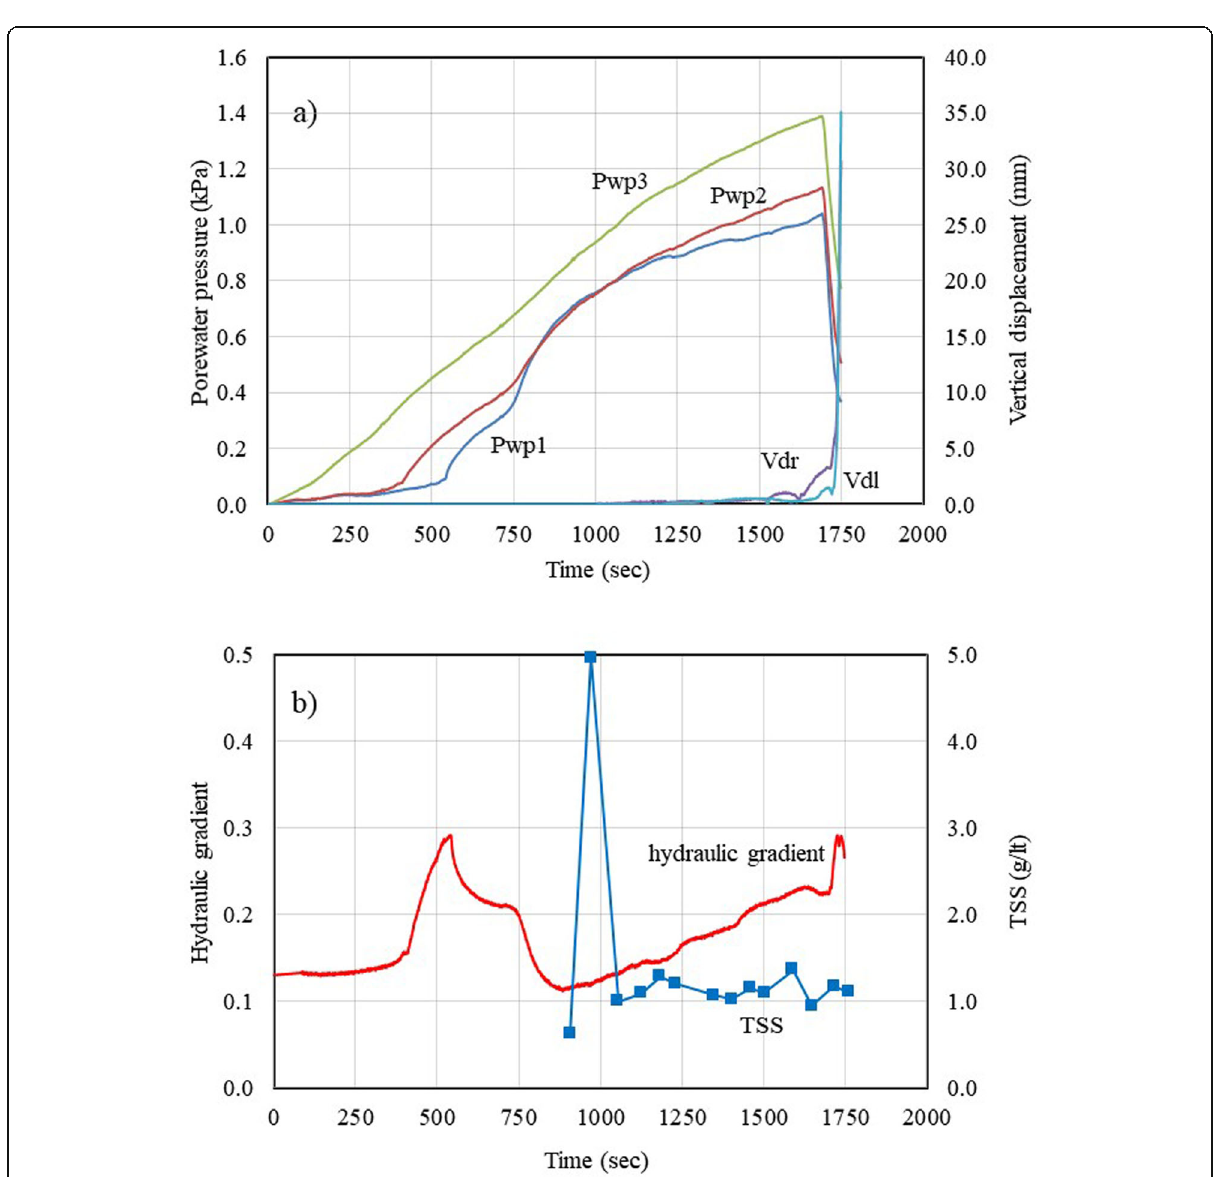
Fig. 6 Experiment results of experiment No. EXP 6F of GIII sample. a Pore water pressure and vertical displacement b Hydraulic gradient and